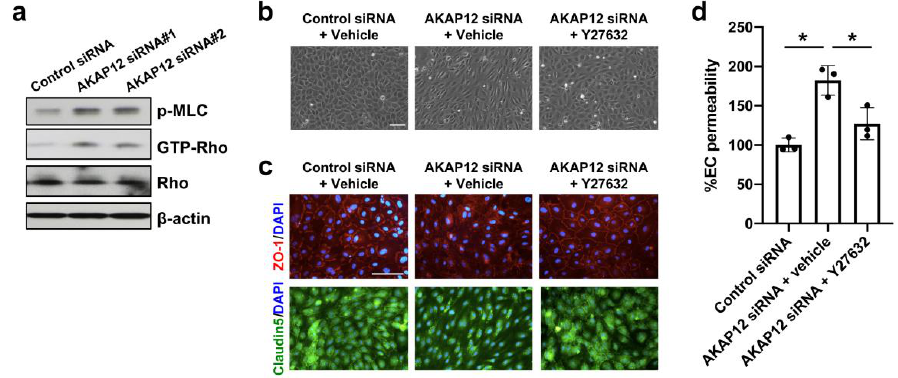
Figure 4. Rho kinase and in vitro endothelial permeability: ( a ) In cultured cerebral endothelial cells, Akap12 siRNAs (siRNA#1 and siRNA#2) activated the Rho kinase pathway. ( b – c ) Rho kinase inhibitor Y-27632 (10 µM) ameliorated the morphology change and ZO-1/Claudin 5 disruption in AKAP12-deficient cells. Scale bar = 100 µ m. ( d ) The increase of in vitro endothelial permeability in AKAP12-deficient cells was also relieved by Y-27632. Mean ± SD of n = 3. * p < 0.05. One-way ANOVA followed by post-hoc Tukey’s multiple comparisons test. Int. J. Mol. Sci. 2020 , 21 , x FOR PEER REVIEW